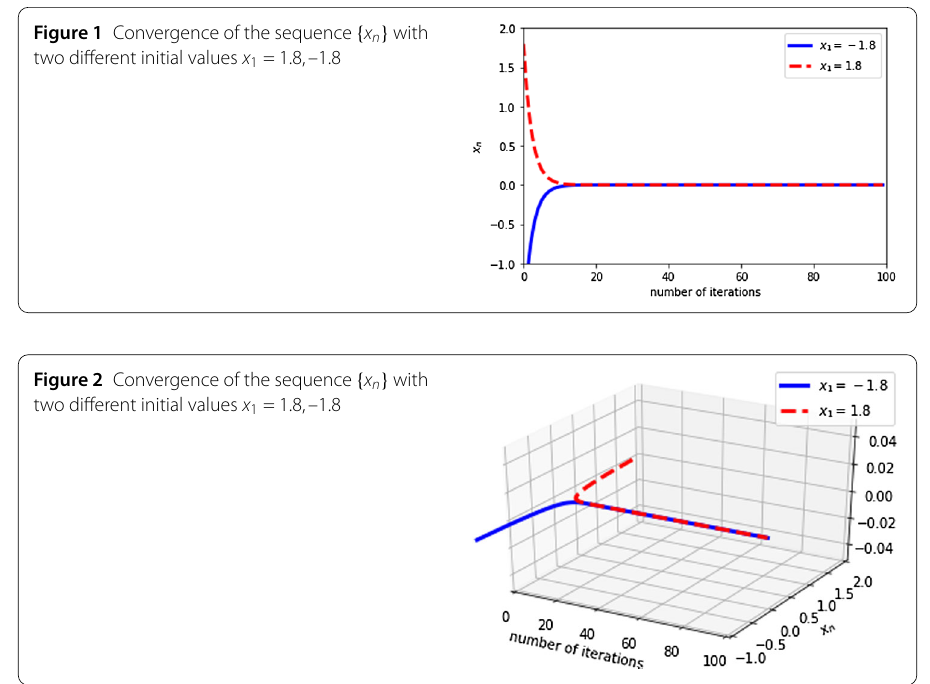
Figure 1 Convergence of the sequence { x n } with two different initial values x 1 = 1.8,–1.8